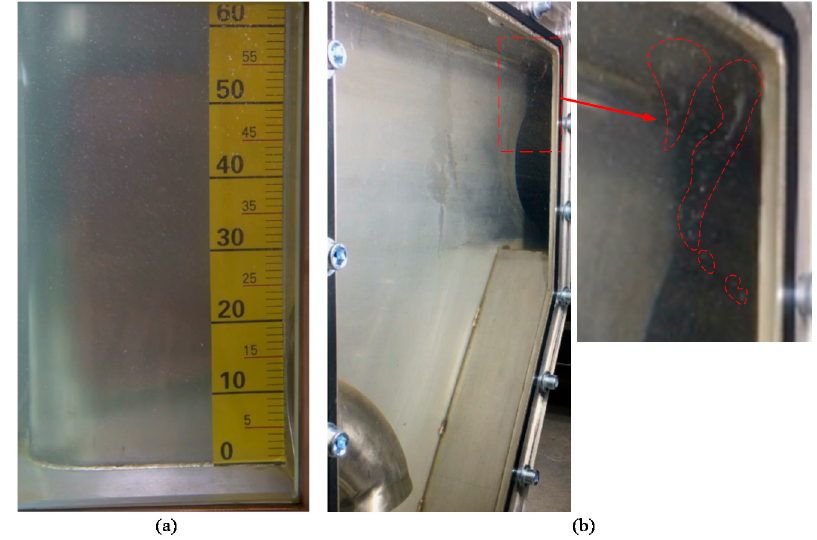
Figure 6. The flow patterns in primary and secondary pump intakes for case 1. ( a ) No obvious vortices in the primary pump intake, ( b ) level IV sub-surface vortex in the vicinity of the inlet of pump 3 on the top wall of the secondary pump intake.